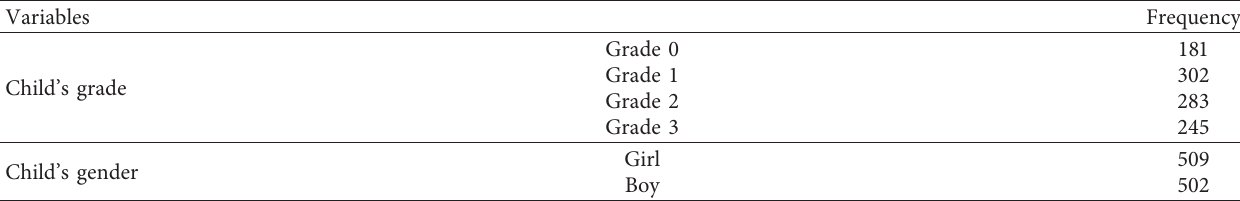
Table 6: Children’s information.